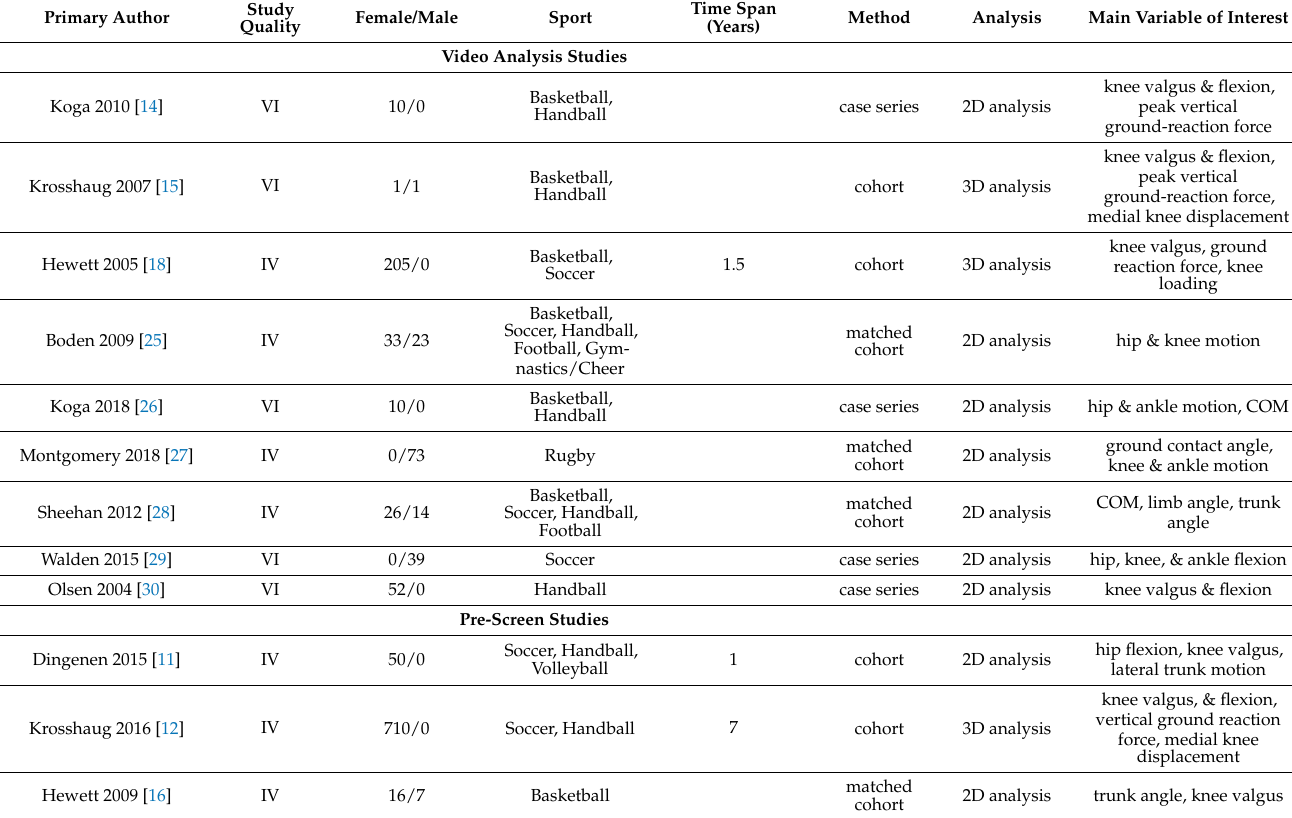
Table 1. Demographic, Method, and Variable Breakdown by Studies